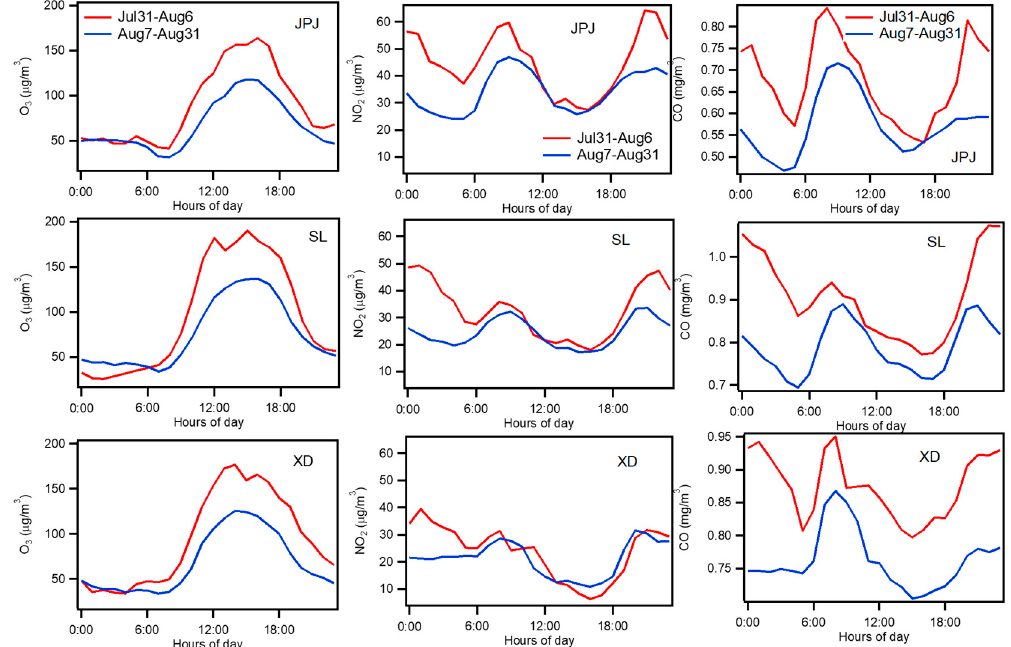
Figure 3. The diurnal profiles of O 3 , NO 2 , CO concentrations at each site before (red line: July 31 – August 6) and during (blue line: August 7 – August 31) control periods. Table 1. Mean value of O 3 concentrations and ambient air pollutants before and during control periods at each monitoring site.